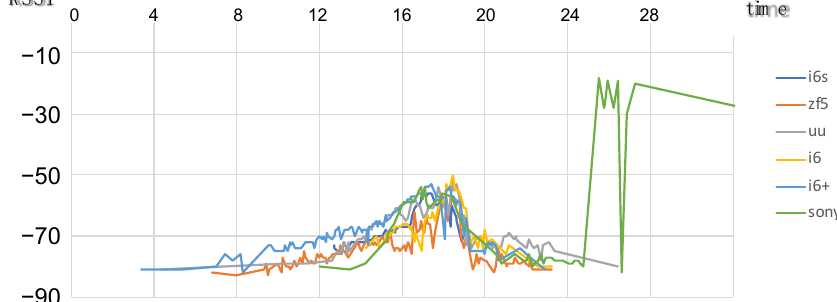
Figure 8. An observation of collected Wi-Fi signal raw data of six smartphones.